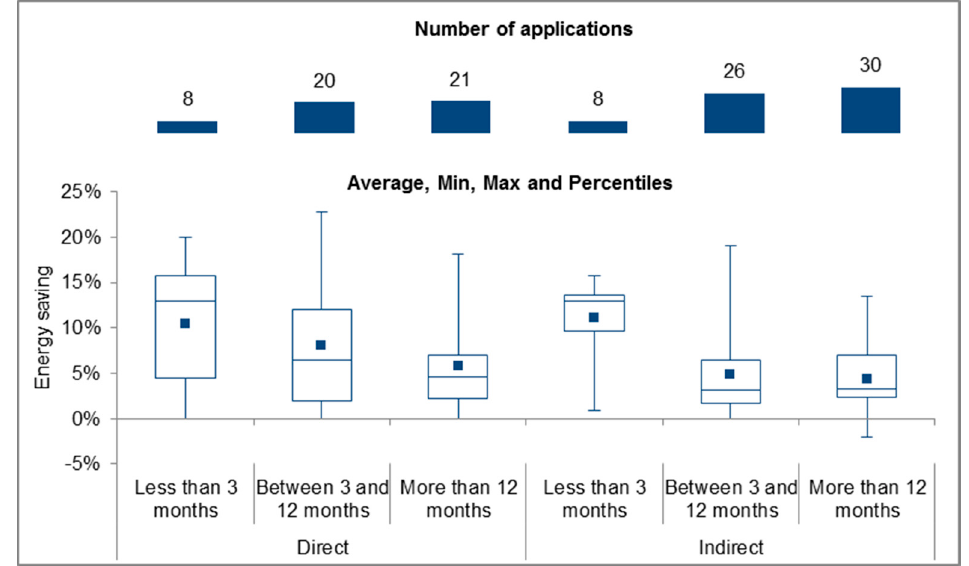
Figure 9. Number of studies and statistical analysis of energy savings associated to feedback, per type of feedback, and duration (based on 113 out of 114 feedback applications).